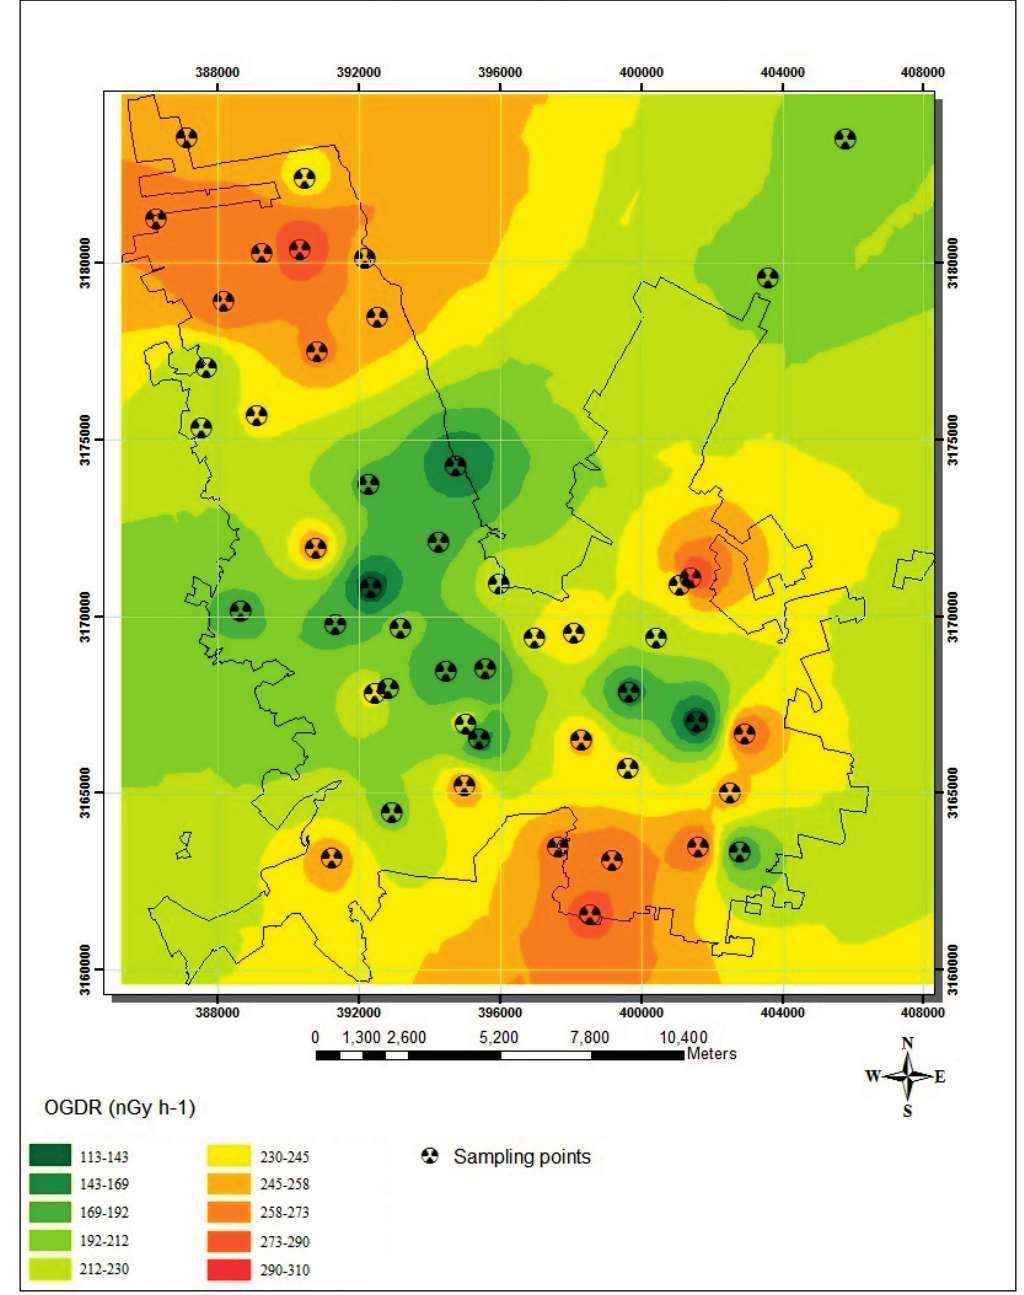
Figure 2. Spatial distribution of outdoor gamma dose rates in Chihuahua